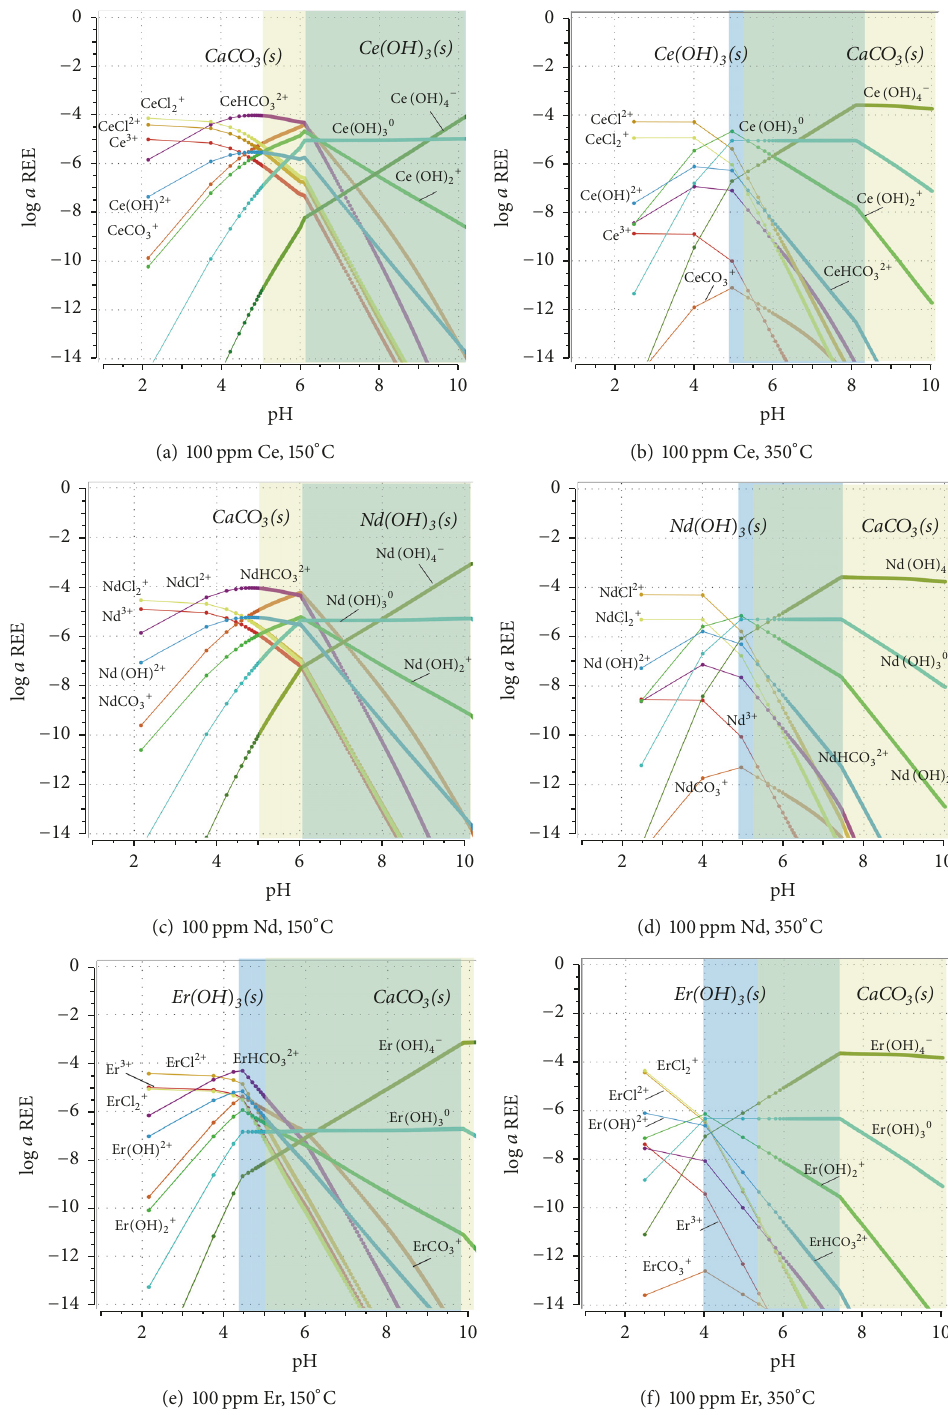
Figure 2: Model Ib (CO 2 -rich, NaCl-poor) showing the speciation of REE in a deeper carbonatite system. Results show the speciation of Ce, Nd, and Er as function of pH at 150 to 350 ∘ C and 1kbar. The starting fluid had a composition of 100 ppm REE, 𝑋 CO 2 of 0.1, and 0.5 wt.% NaCl. The blue field represents the field of REE(OH) 3 (s) stability, while the yellow field corresponds to the stability field of